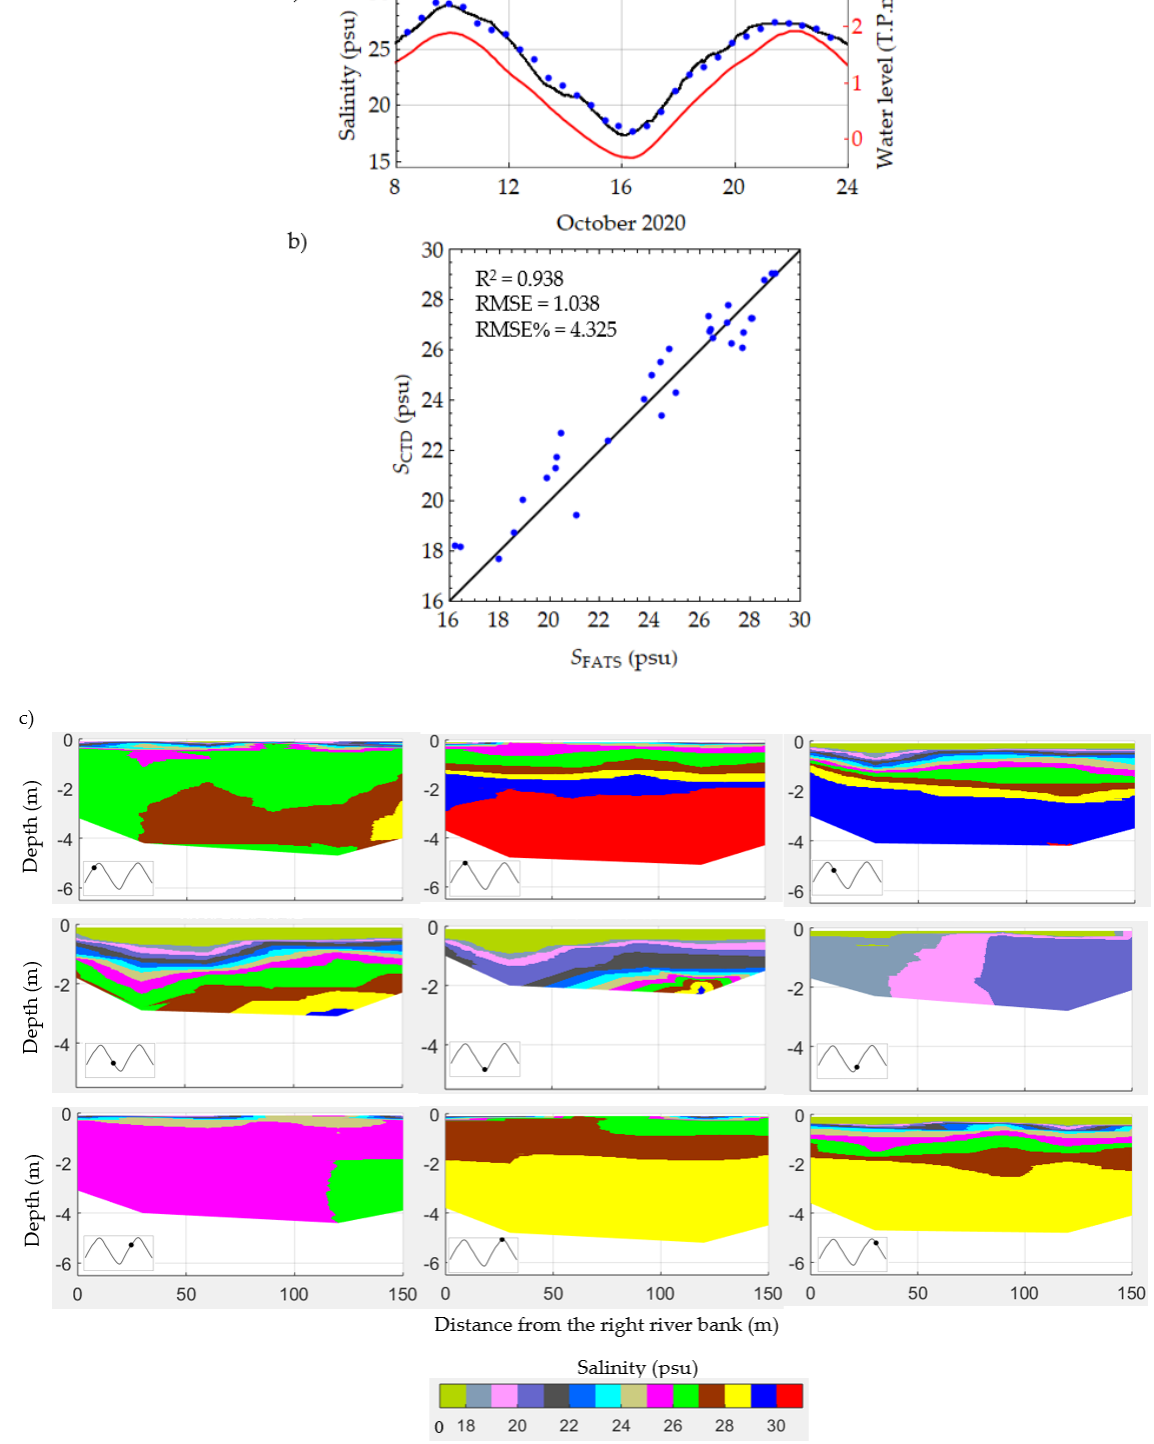
Figure 8. ( a ) Water level at Gion Gauging Station (red line), and the comparison between the salinity acquired using FAT (black line) and Compact CTD (blue dots) at Shinkoi Bridge, ( b ) The association between the FAT and Compact CTD estimates, and ( c ) Vertical salinity profile obtained using Compact